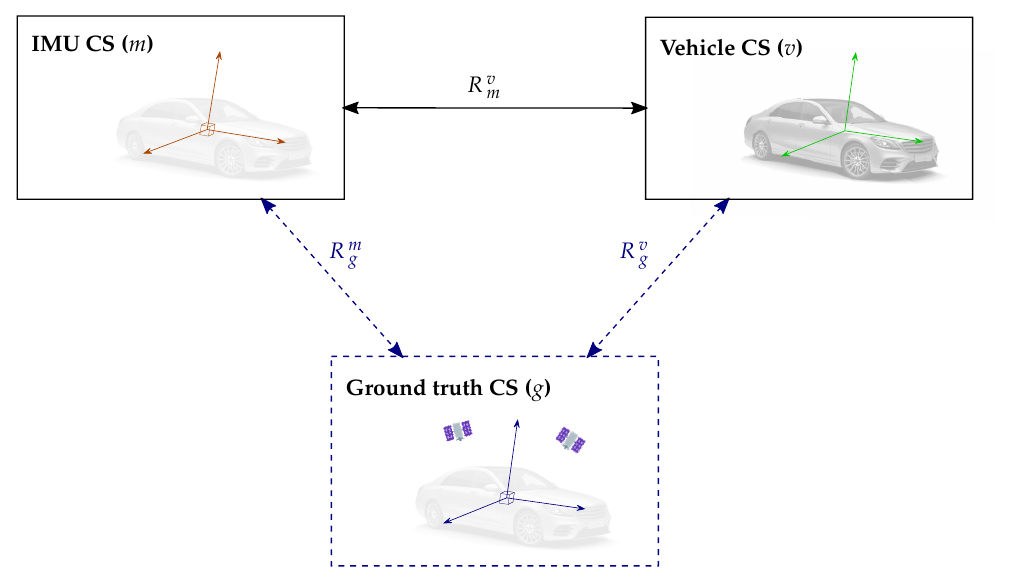
Figure 1. The present work proposes an approach to estimate the 3D rotation between the IMU and vehicle coordinate systems ( R v m ). Additionally, calibration procedures are described to determine the 3D rotation between a ground-truth measurement system and both the IMU and vehicle coordinate systems ( R m g and R v g , respectively). These represent a reference to directly assess the accuracy of the estimated IMU–vehicle 3D